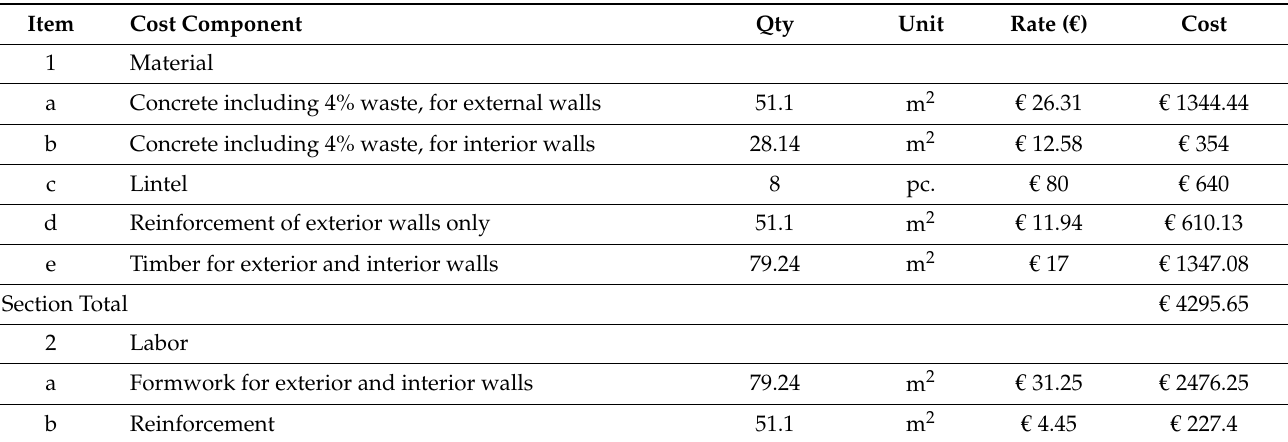
Table A7. Scenario 6 cost model in